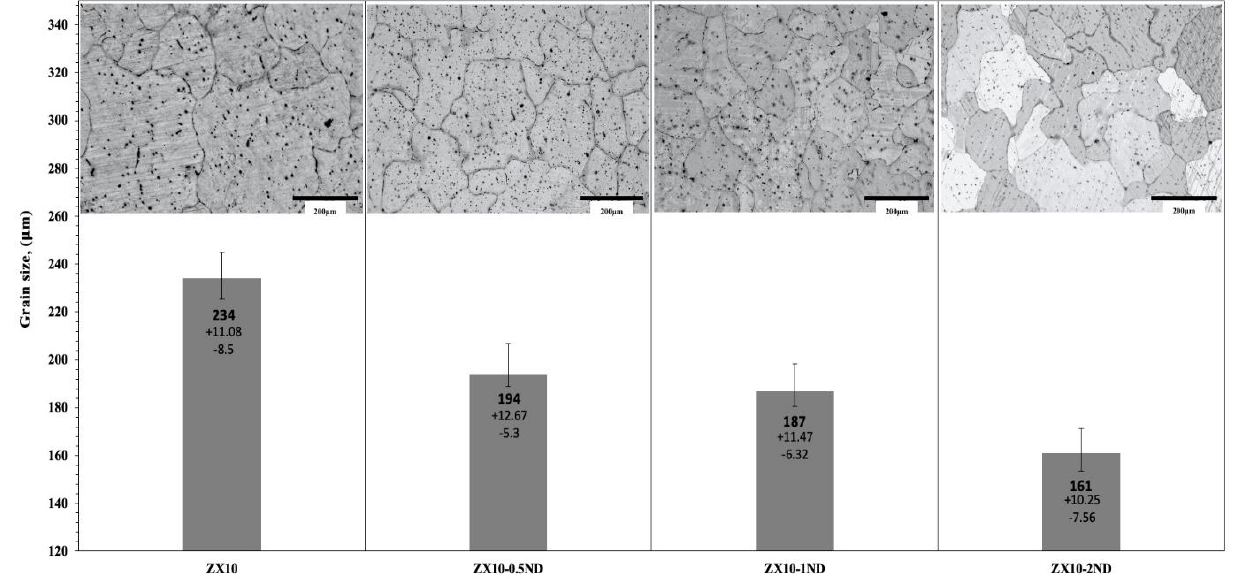
Figure 4. The grain size of the alloy and nanocomposites. SEM, applied at different magnifications of the ZX10 alloy, and of the